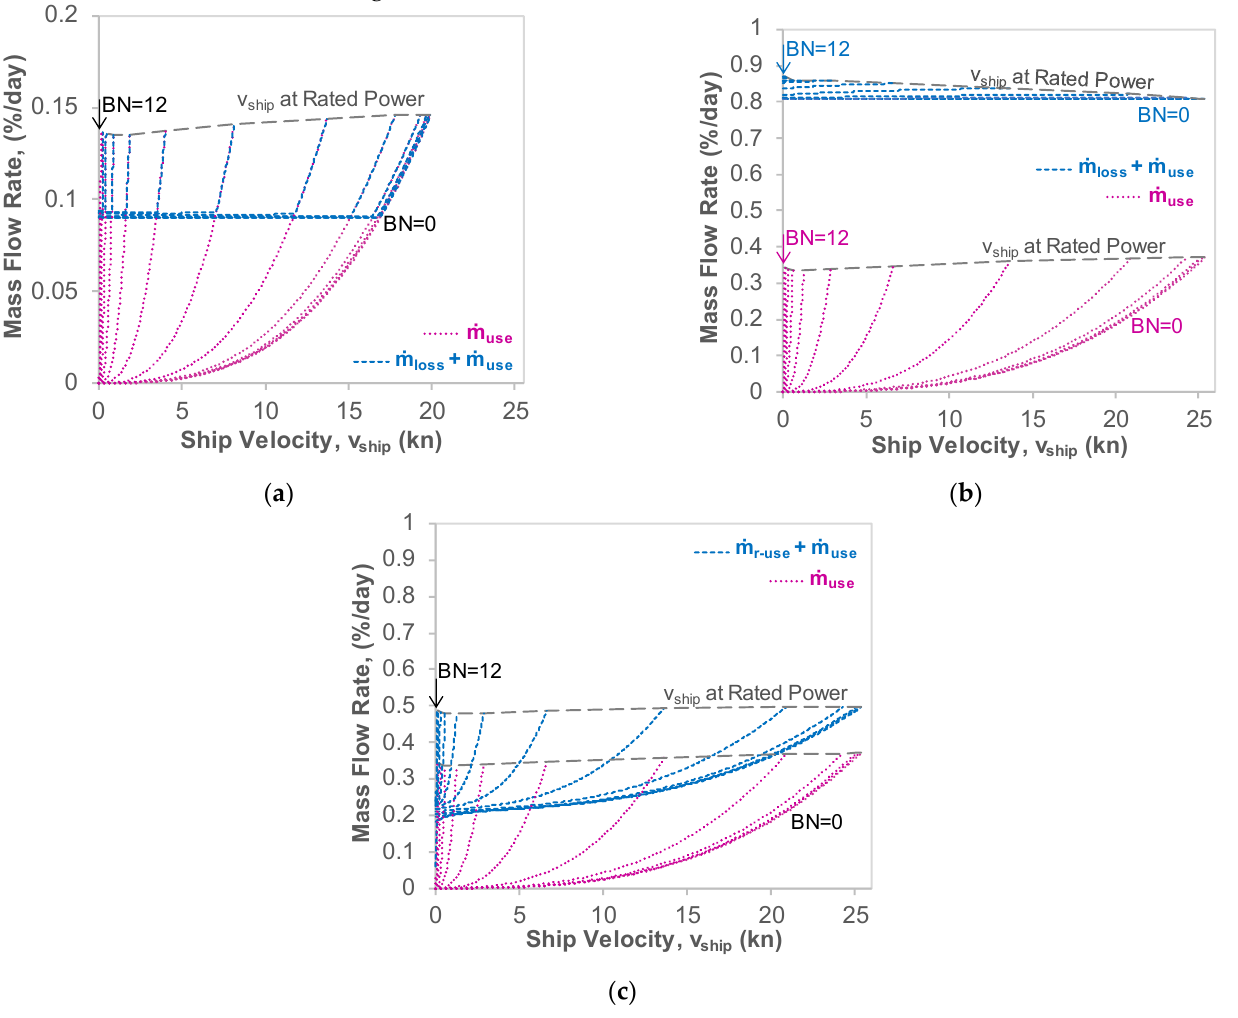
Figure 5. Variation of key mass flow rates with Beaufort number (BN) and ship velocity ( v ship ). The trends shown are: ( a ) fuel utilisation rate for propulsion ( m ̇ use ) and BOR ( m ̇ loss +m ̇ use ) for an existing LNG ship model; ( b ) fuel utilisation rate for propulsion ( m ̇ use ) and BOR ( m ̇ loss +m ̇ use ) for an LH2 combustion ship with the same tank insulation thickness as the LNG ship, without reliquefaction; ( c ) fuel utilisation rates for propulsion ( m ̇ use ) and reliquefaction ( m ̇ r-use ) for an LH2 combustion ship with the same tank insulation thickness as the LNG ship, with reliquefaction.